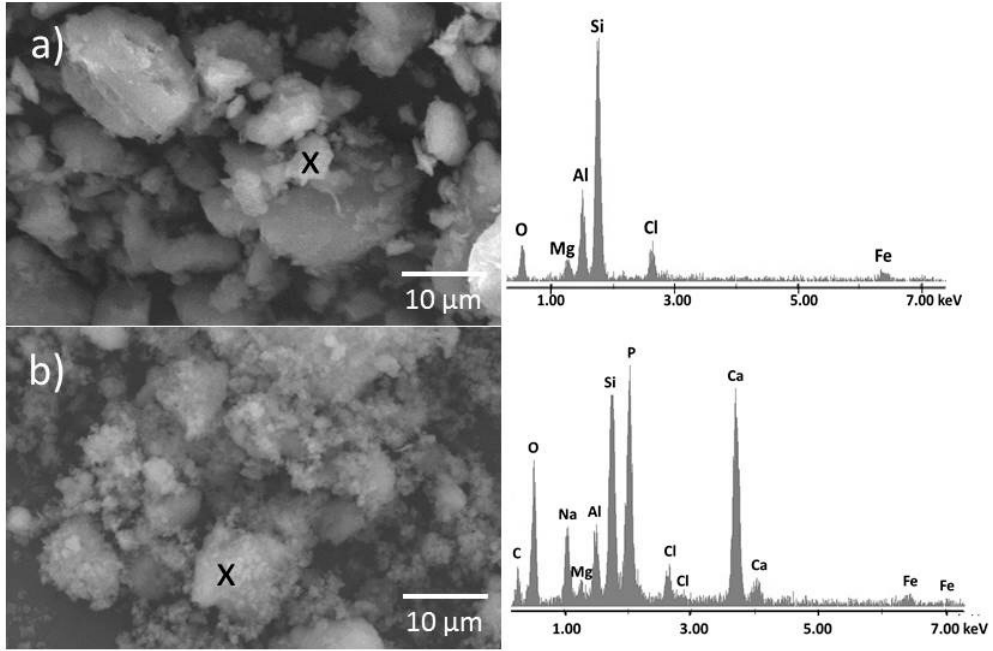
Figure 6. SEM image of ( a ) MCA and ( b ) MCAH with adequate representative EDS analysis.